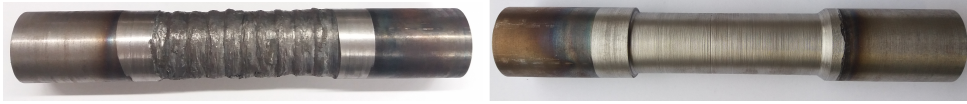
Figure 5. Specimens made using WAAM process. ( left ) Specimen without any outer surface treat- ment, ( right ) specimen, where the outer surface is machined off.